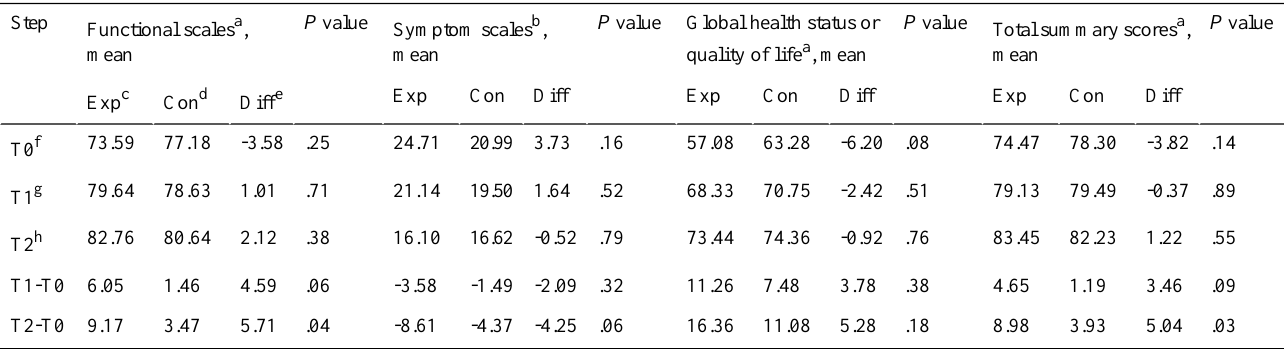
Table 3. Generalized estimating equation analysis of longitudinal outcome of the Quality-of-Life Questionnaire Core 30 (N=112).